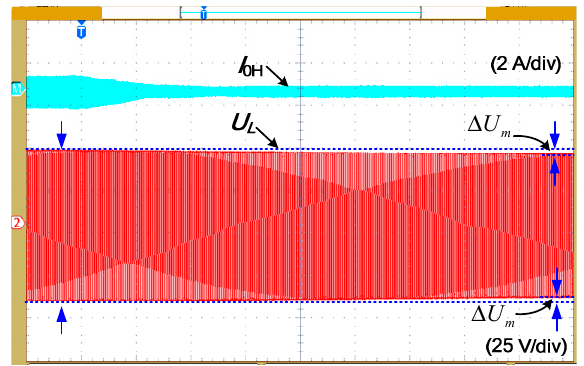
Figure 12. The circulating current and PCC voltage of DGs using the adaptive virtual impedance method.